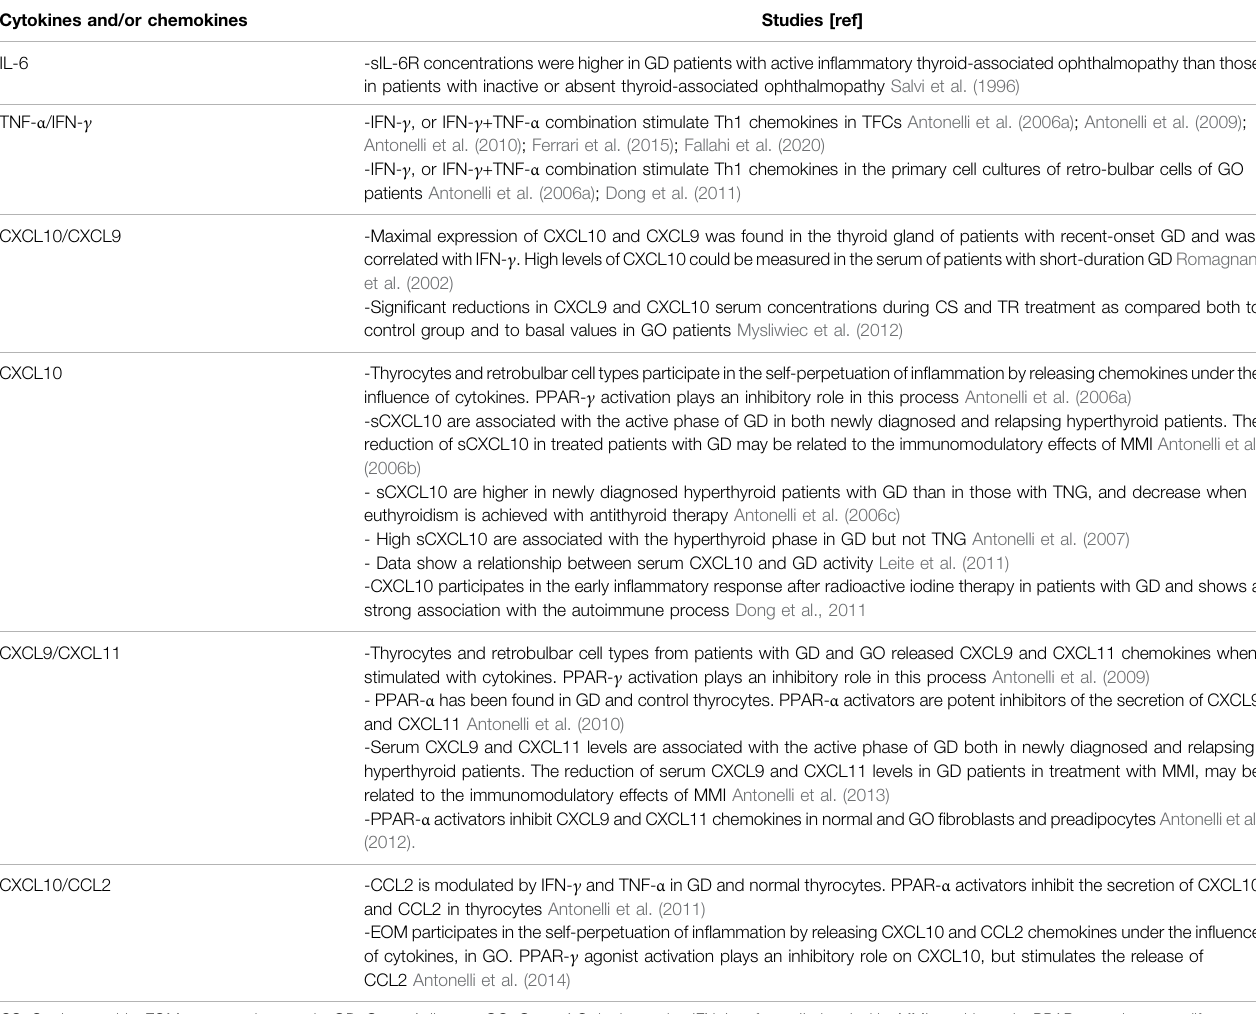
TABLE 1 | Cytokines and/or Chemokines in Graves ’ disease and in Graves ’ Ophtalmopathy. Cytokines and/or